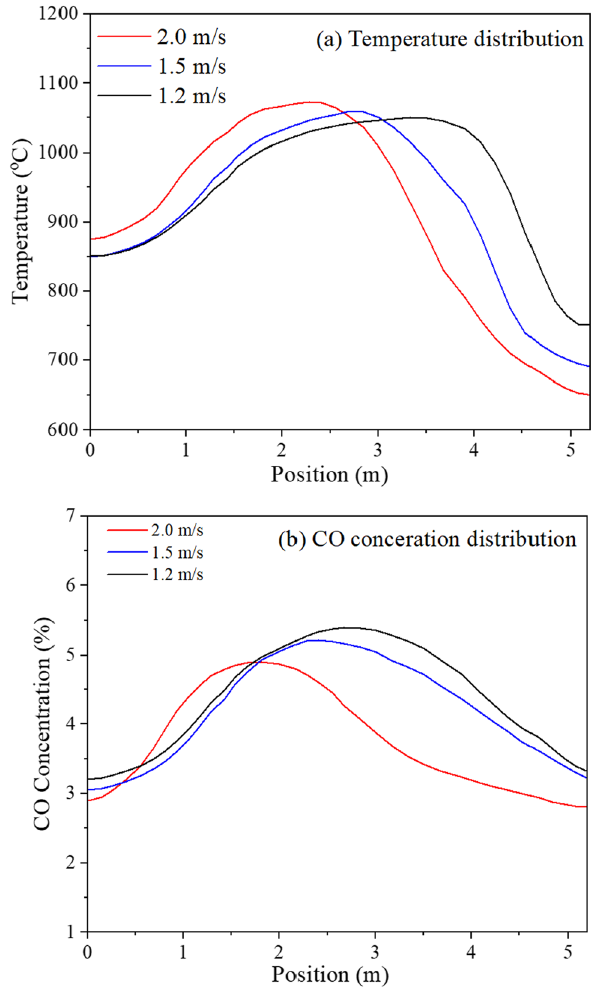
Fig. 7 Simulation results at different wind speeds